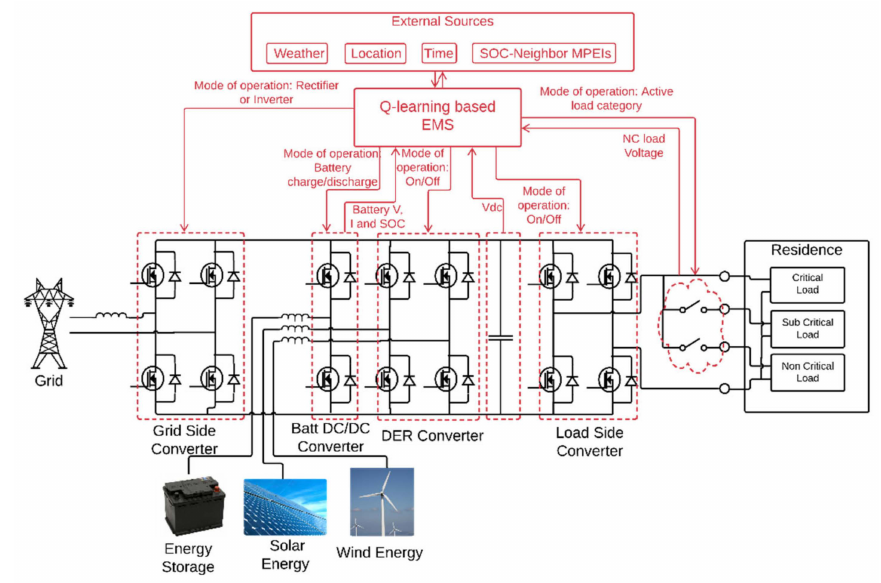
Figure 2. System schematic with MPEI and Q-learning-based